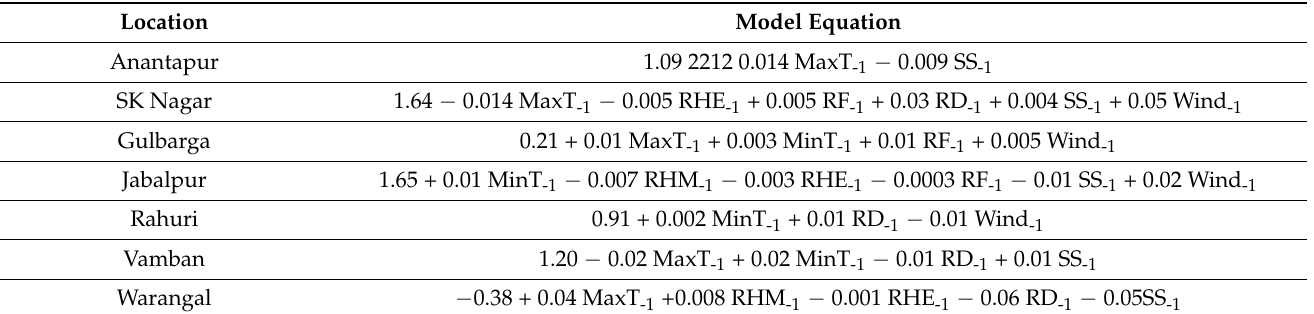
Table 6. Stepwise regression models for prediction of spiders.